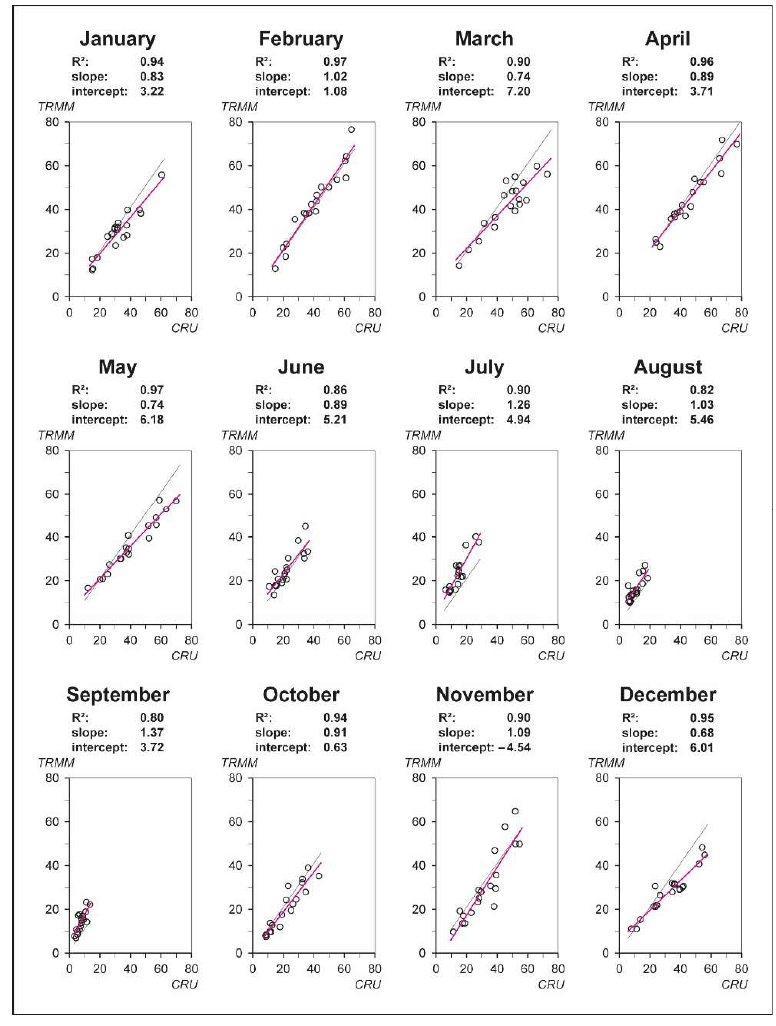
Figure 3. Monthly comparison between CRU TS4.01 and TRMM 3B43 for the period 1998–2016. The solid pink line is the linear regression and the solid black one is the 1:1 line.